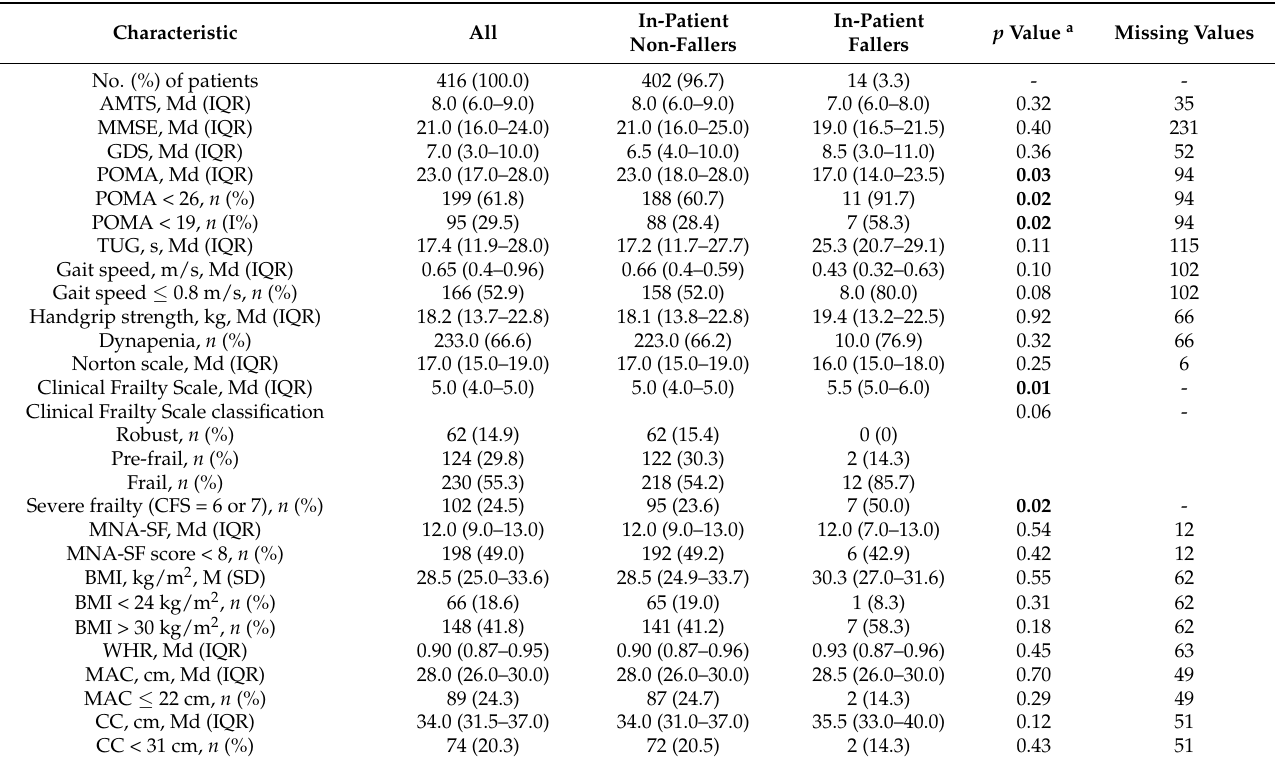
Table 3. Characteristics of study participants—mental and physical abilities and nutritional correlates of